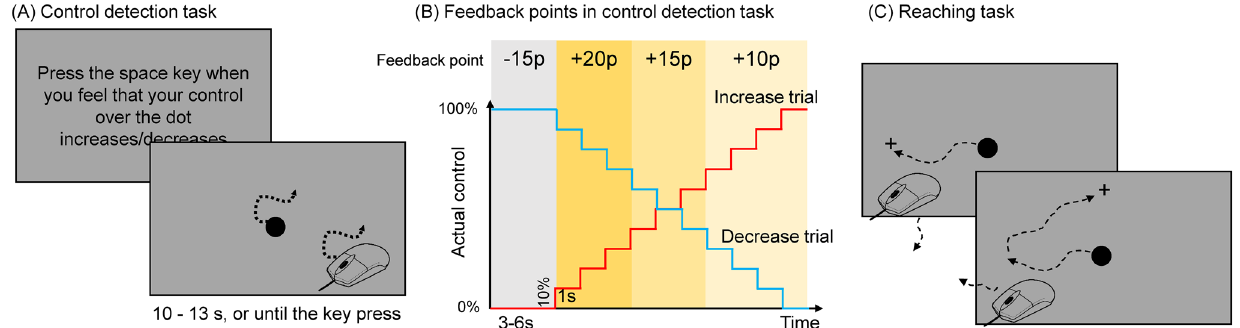
Figure 1. Two experimental tasks. ( A ) Shows an example of the screen in the control detection task, and ( B ) shows the feedback points in that task. ( C ) shows an example of the screen in the reaching